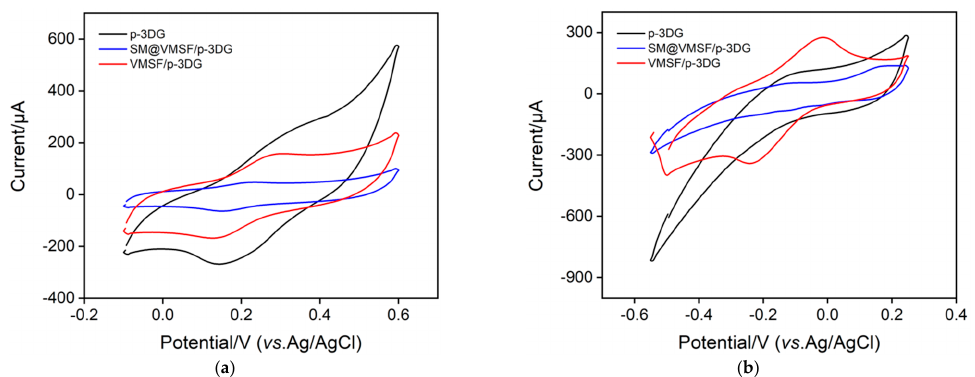
Figure 3. CV curves obtained on different electrodes in 0.05 M KHP solution (pH = 4) containing 0.5 mM Fe(CN) 63 − ( a ) or 0.5 mM Ru(NH 3 ) 63+ ( b ).